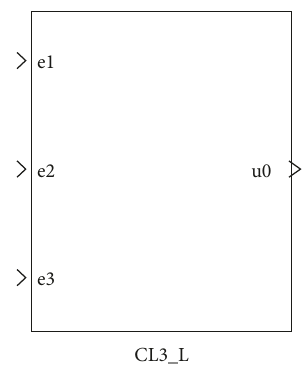
Figure 17: Packaged CL3_L subsystem